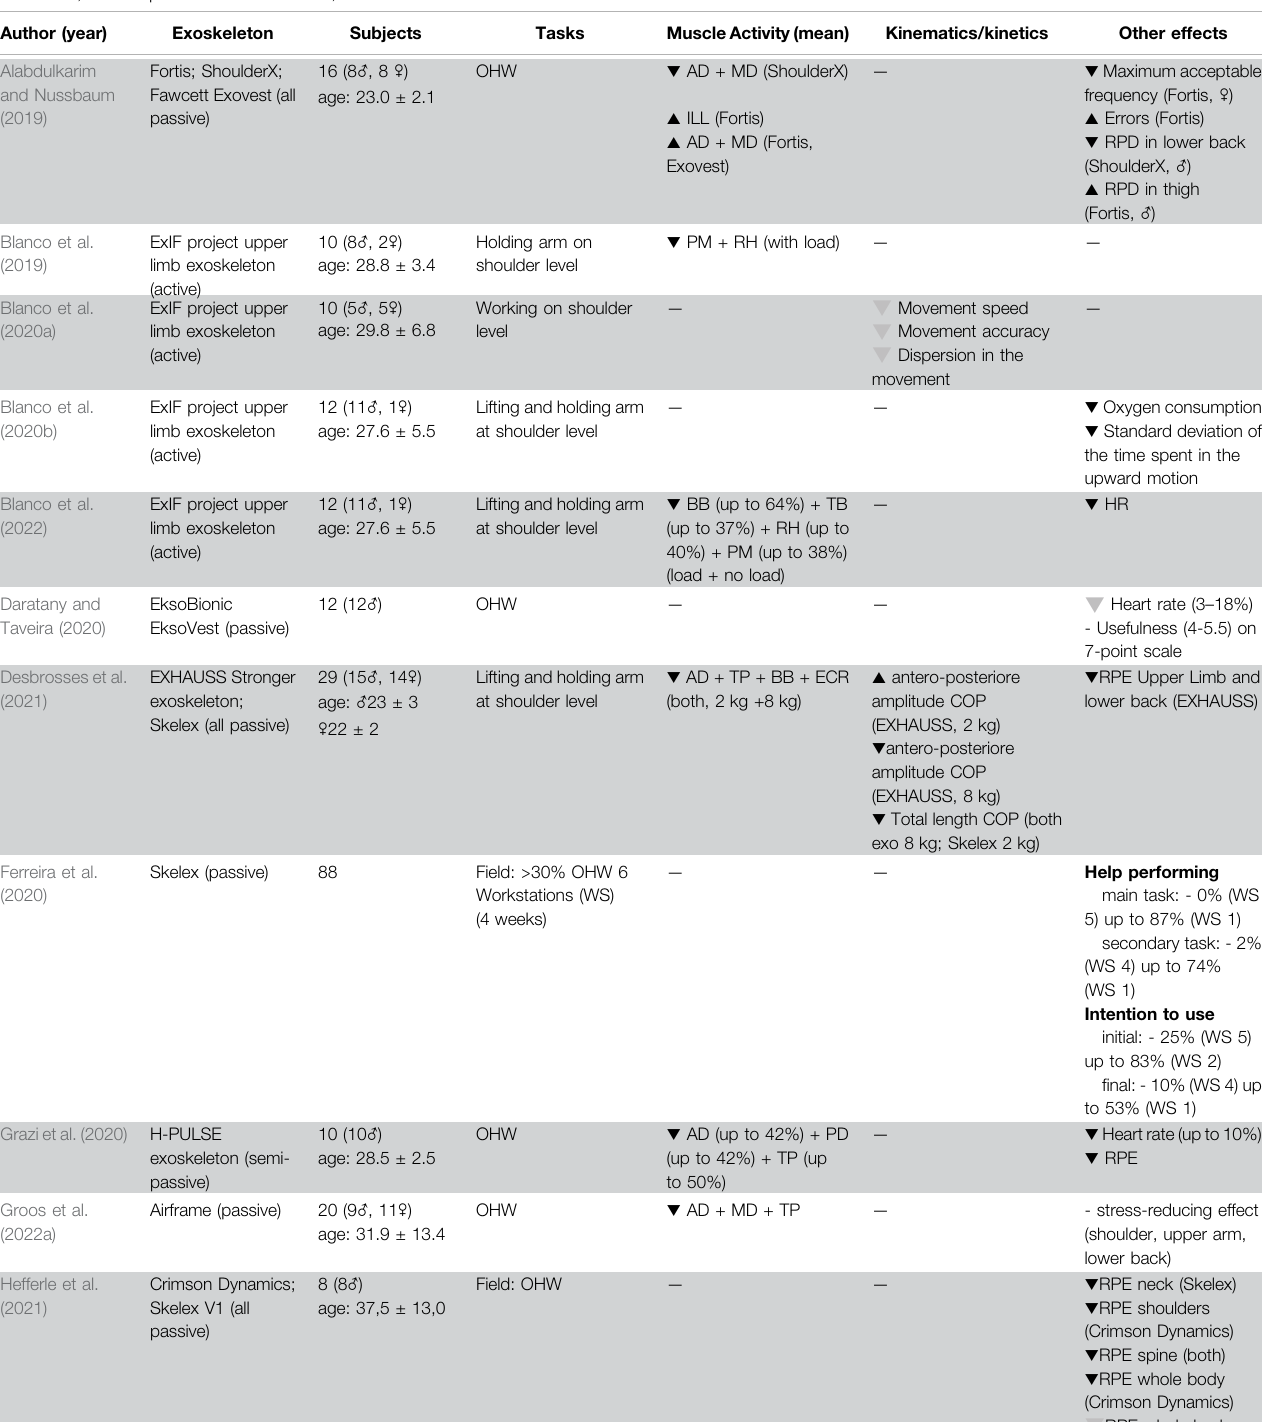
TABLE 1 | Overview and brief description of included studies ( ▲ and ▼ indicate statistically signi fi cant higher/lower values compared to the execution without exoskeleton, unless speci fi ed otherwise; ▲ and ▼ indicate statistically not signi fi cant higher/lower value compared to the execution without exoskeleton, unless speci fi ed otherwise; OHWoverheadwork;RPEratingsofperceivedexertion;RPDratingsofperceiveddiscomfort;ROMrangeofmotion;COPcenterofpressure;n.r.notreported;muscles:AD anterior deltoid; MD middle deltoid; PD posterior deltoid; IN infraspinatus; BB biceps brachii; BR brachioradialis; TB triceps brachii; ECR extensor carpi radialis; FCR fl exor carpi radialis; ILL iliocostalis lumborum pars lumborum; LD Latissimus dorsi; RH rhomboids; TP trapezius; PM pectoralis major; SE serratus anterior; RA rectus abdominis; OE obliquus externus abdominis; TBA tibialis